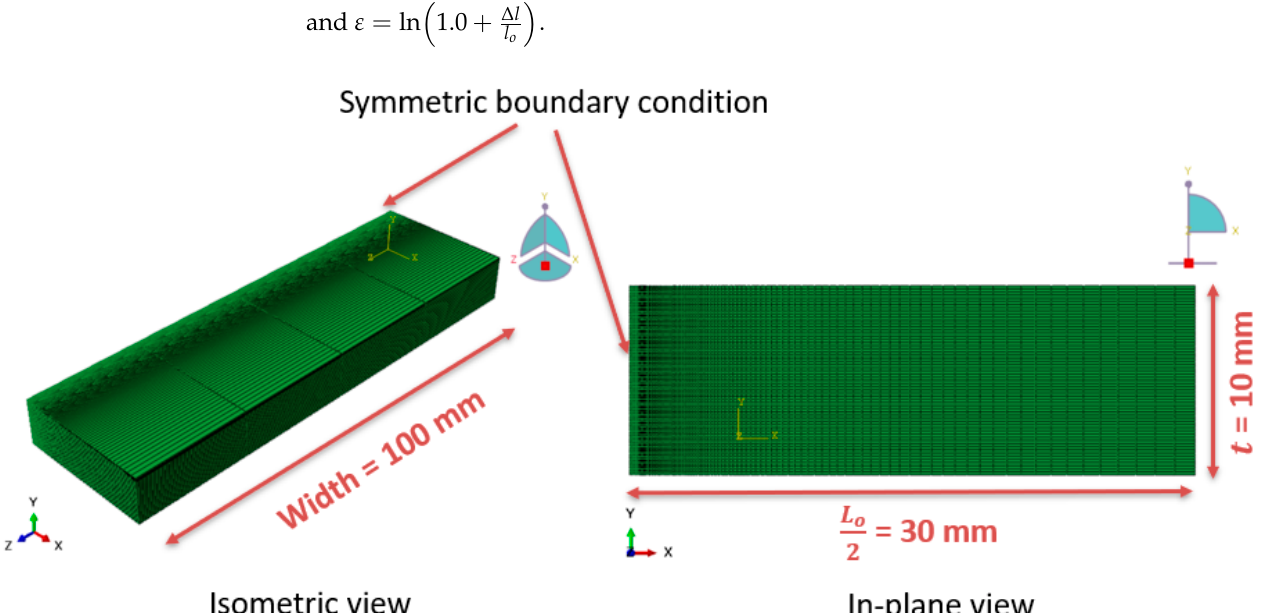
Figure 3. Finite element (FE) configuration of a specimen under tension.